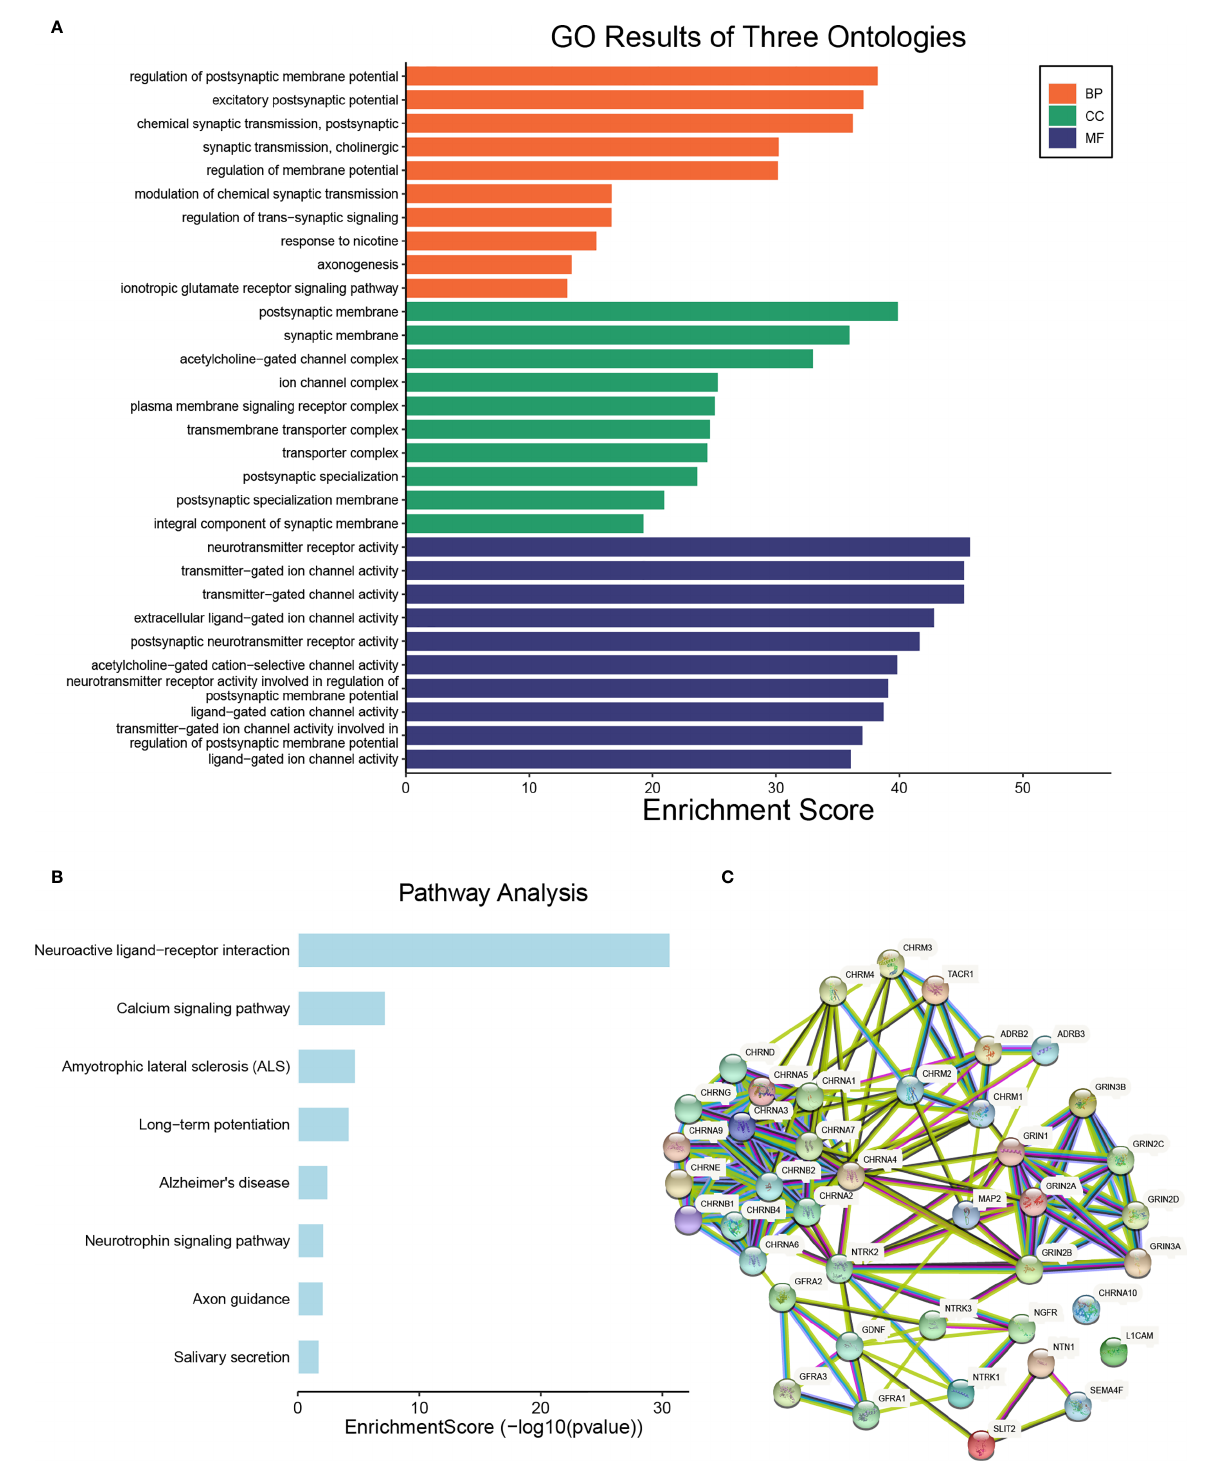
Frontiers in Oncology |